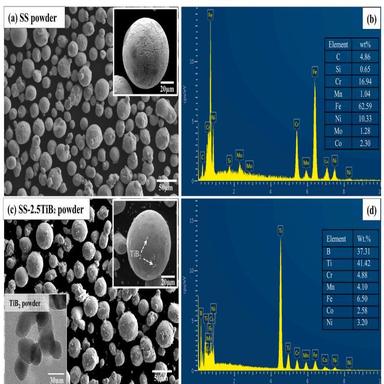
SEM images of (a) stainless steel powders, (c) mixture powders of stainless steel and 2.5 vol% of TiB2 nanoparticles and (b and d) their EDS analysis results.